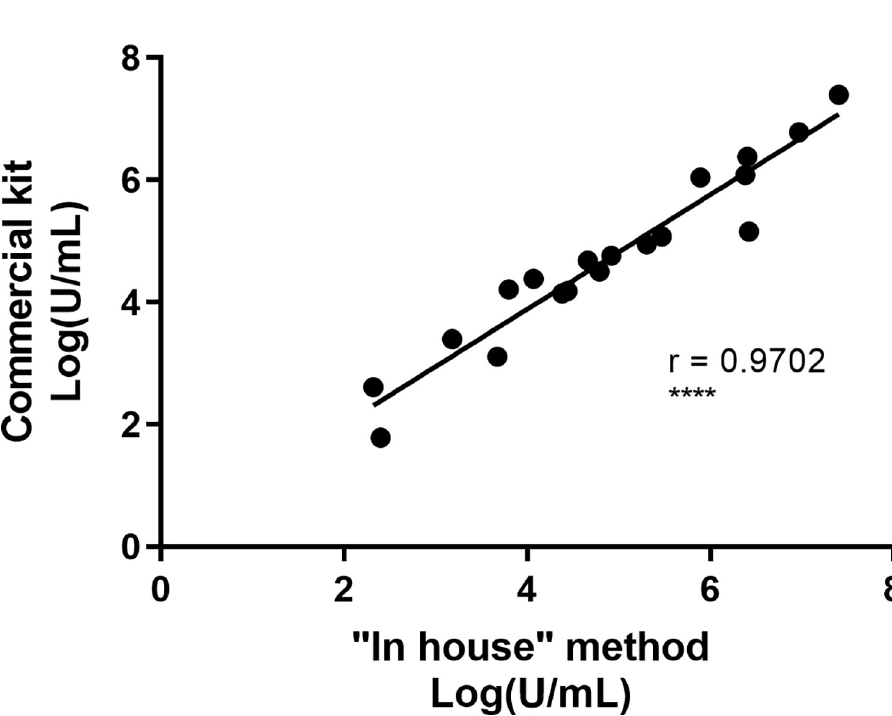
Fig 3. Validation of the DNA extraction method using commercial kit (GenoLyse). Nineteen positive samples were extracted with the “in house” method followed by purification on Qiagen column versus the commercial kit. Validation of the commercial kit for DNA extraction was evaluated with Spearman’s correlation test. Each dot corresponds to a sample. The x and y axes indicate the logarithm of M . ulcerans DNA concentration. Spearman’s correlation coefficient = 0.9702. ���� , Correlation was statistically significant with p < 0.0001. No significant difference was observed between the “in-house” method and the commercial kit (Wilcoxon test).